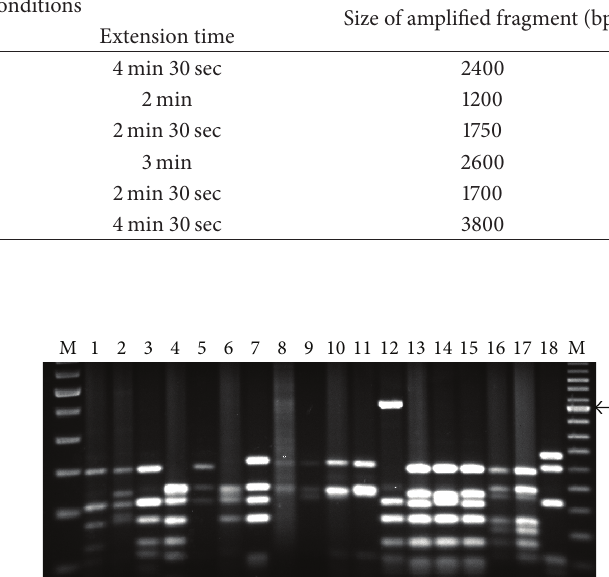
Table 2: PCR conditions and size of amplified fragments in wild brassicas using six universal primer pairs. Abbreviation of cpDNA primers a